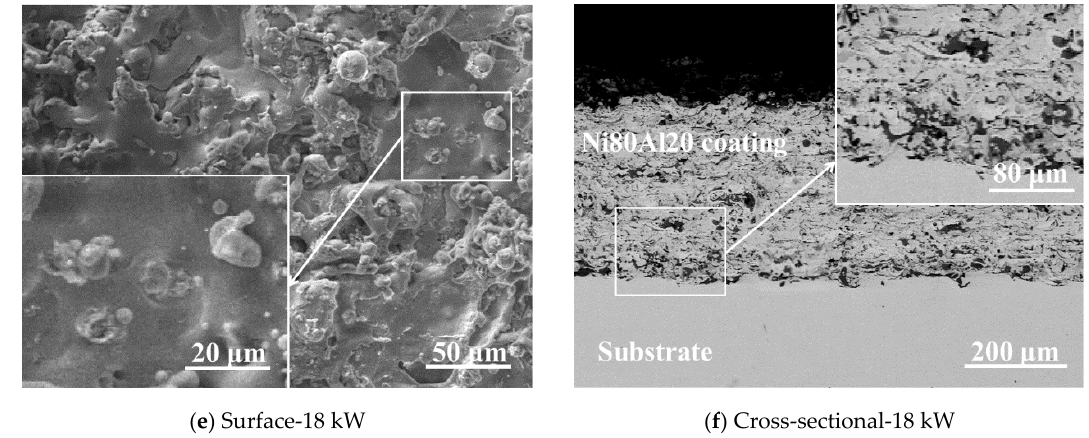
Figure 5. Micromorphology of Ni80Al20 coatings formed under different spraying powers: ( a ) Surface-12 kW, ( b ) Cross-sectional-12 kW, ( c ) Surface-15 kW, ( d ) Cross-sectional-15 kW, ( e ) Surface-18 kW and ( f ) Cross-sectional-18 kW.